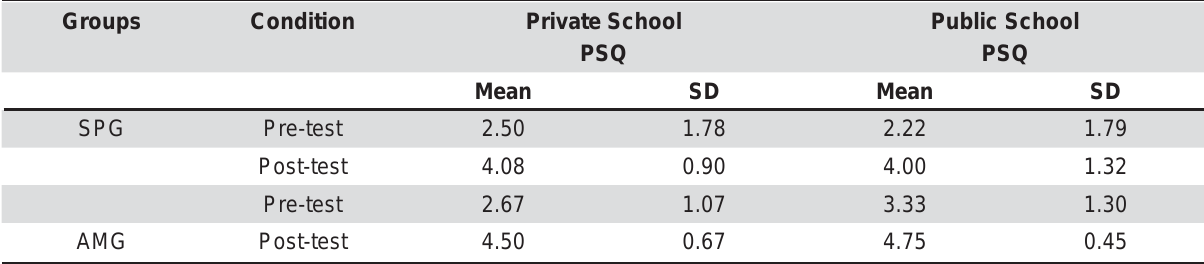
Table 1- Mean and standard deviation of the Problem Situation Questionnaire, under pre- and post-test conditions, according to group and type of school